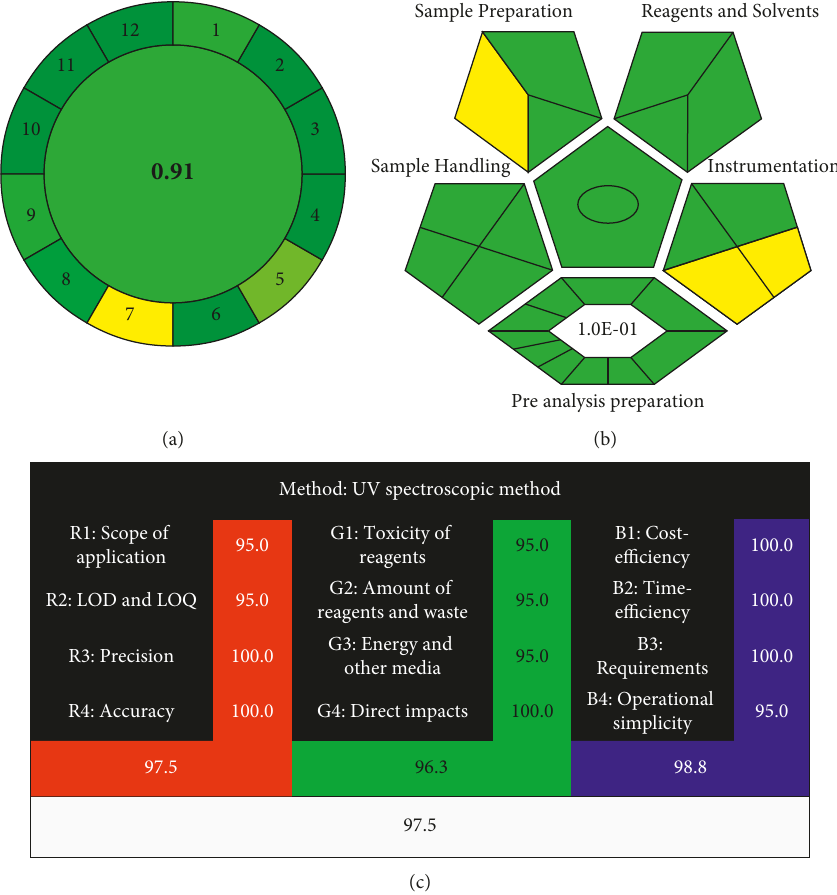
Figure 6: Green evaluation results of UV spectroscopic method by (a) AGREE, (b) ComplexGAPI, and (c) white analytical